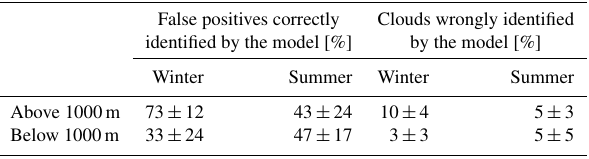
Table 1. Evaluation of the model’s effects on MODIS data set us- ing SYNOP data as a reference at 20 SYNOP locations (7 above 1000m, 13 below; 4 stations with limited overlap between SYNOP and the ground-based radiation measurements were excluded). The two left columns contain the percentage of false positives in the satellite data that were correctly identified by the model. The two right ones contain the percentage of clouds identified in the satel- lite data which are considered false by the model, even though they are actual clouds according to SYNOP observations with the binary threshold